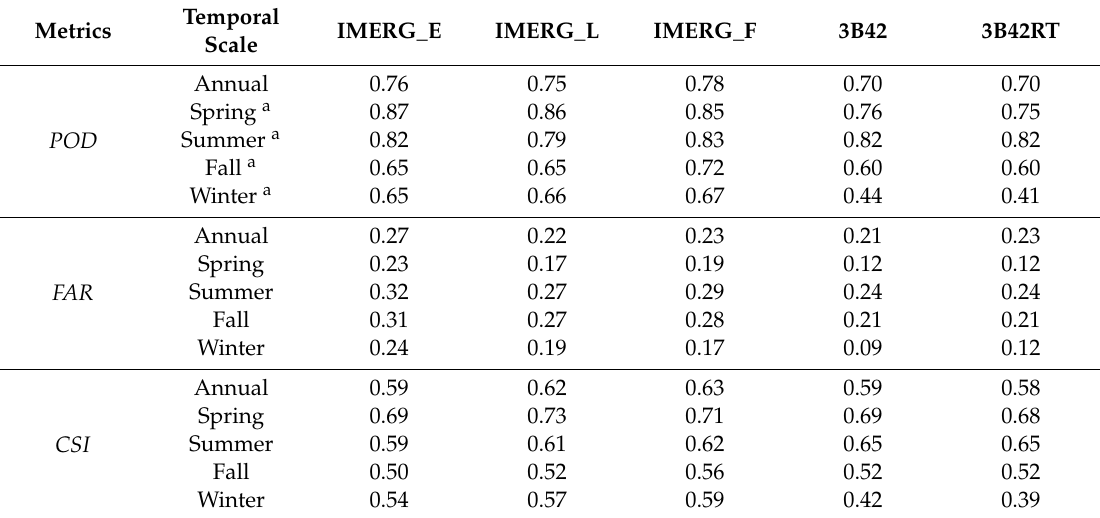
Table 4. Mean categorical evaluation metrics of the SPPs at daily